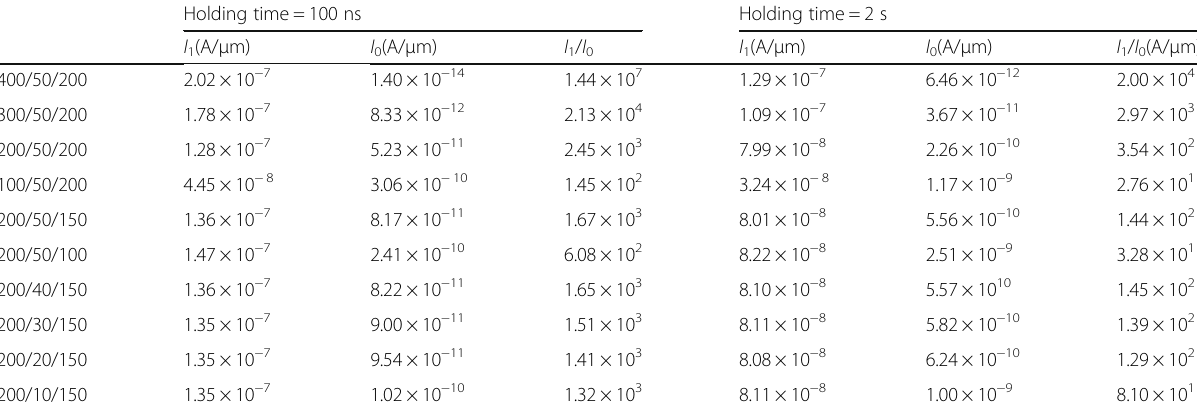
Table 4 Extracted performance properties of S/S/H with the decreasing of device size Holding time = 100